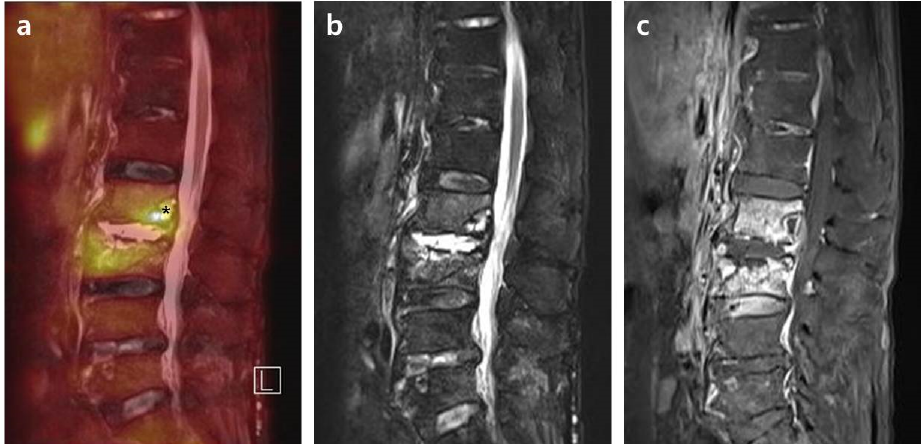
Figure 2. Simultaneous FDG-PET/MRI with the location of SUV max on the vertebral body after successful antimicrobial therapy. A 77-year-old female patient shows PVO of L2–3 on simultaneous FDG-PET/MRI with SUV max 5.99 on the vertebral body (asterisk) after 31 days of vancomycin (CRP 0.49 mg / dL). In the distribution pattern of the PVO lesion, FDG uptake on FDG-PET ( a ) shows the highest FDG uptake on the vertebral body of L2 and diffuse FDG uptake on L3. High signal intensity on T2FS ( b ) also shows similar distribution pattern of FDG-PET. However, there are significantly increased enhancements and high signal intensity on the overall PVO lesion on T1C ( c ). FDG-PET/MRI, 18 F-fluorodeoxyglucose positron emission tomography/magnetic resonance imaging; SUV max , maximum standardized 18 F-fluorodeoxyglucose uptake value; PVO, pyogenic vertebral osteomyelitis; CRP, C-reactive protein; T2FS, T2-weighted fat saturation magnetic resonance imaging; TIC, T1-weighted contrast magnetic resonance